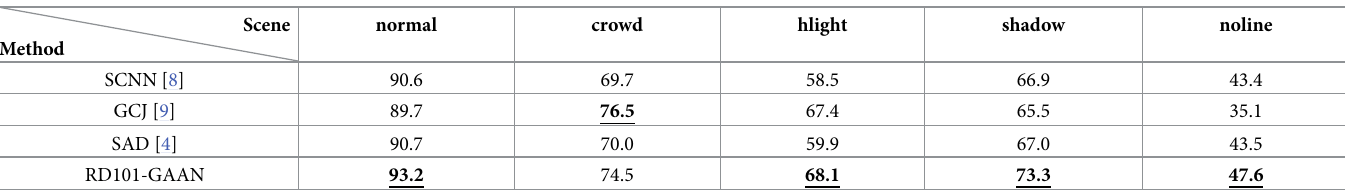
Table 2. F1-Measure of several methods on CULane dataset.